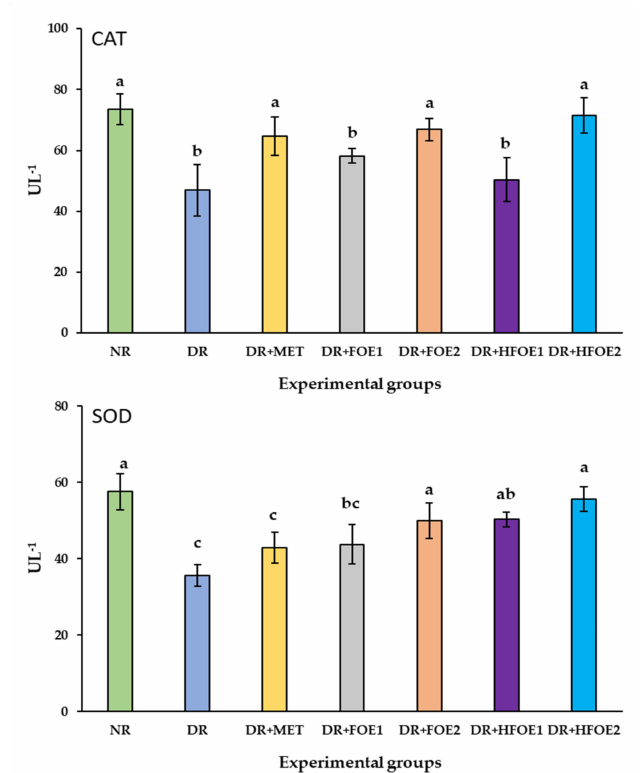
Figure 2. Effect of orally administrated FOE and HFOE on antioxidant biomarkers in streptozotocin- induced diabetes in rats (mean ± SE), n = 8. Experimental groups, see materials and methods; Section 2.8. GSH, reduced glutathione; MDA, malondialdehyde; SOD, superoxide dismutase; CAT, catalase. a–d Bars not sharing similar letters are significantly different ( p >